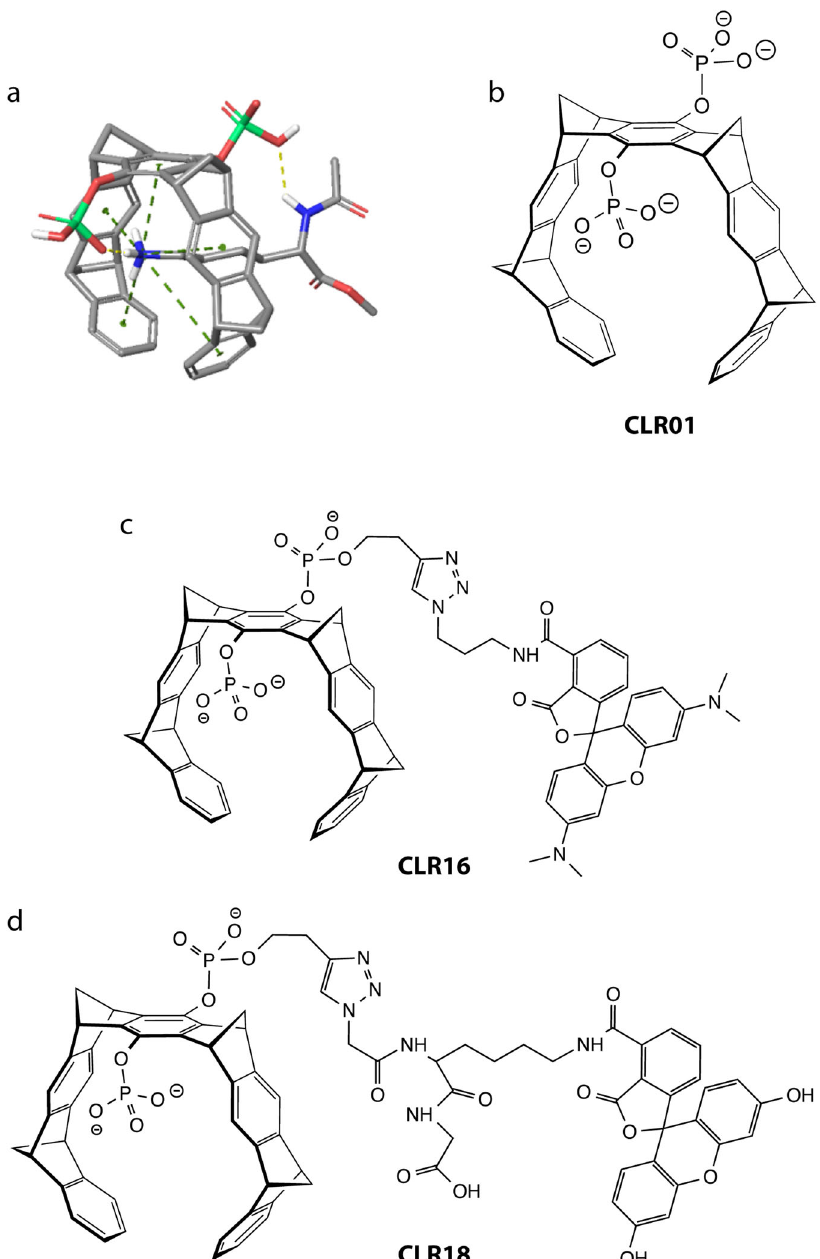
Fig. 1 Schematic structures of MTs. a Schematic representation of the interaction between MTs and Lys. The MT bears two headgroups that may be identical or different. The charge of each headgroup may be 0, − 1, or − 2, which are neutralized by the corresponding number of Na + cations. b CLR01. c CLR16. d CLR18. All the compounds are partially protonated at pH